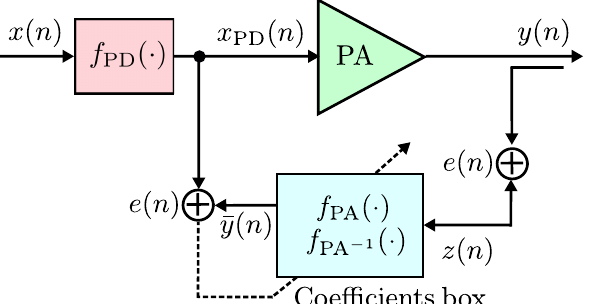
Figure 1. General diagram of the proposed behavioral model on indirect learning